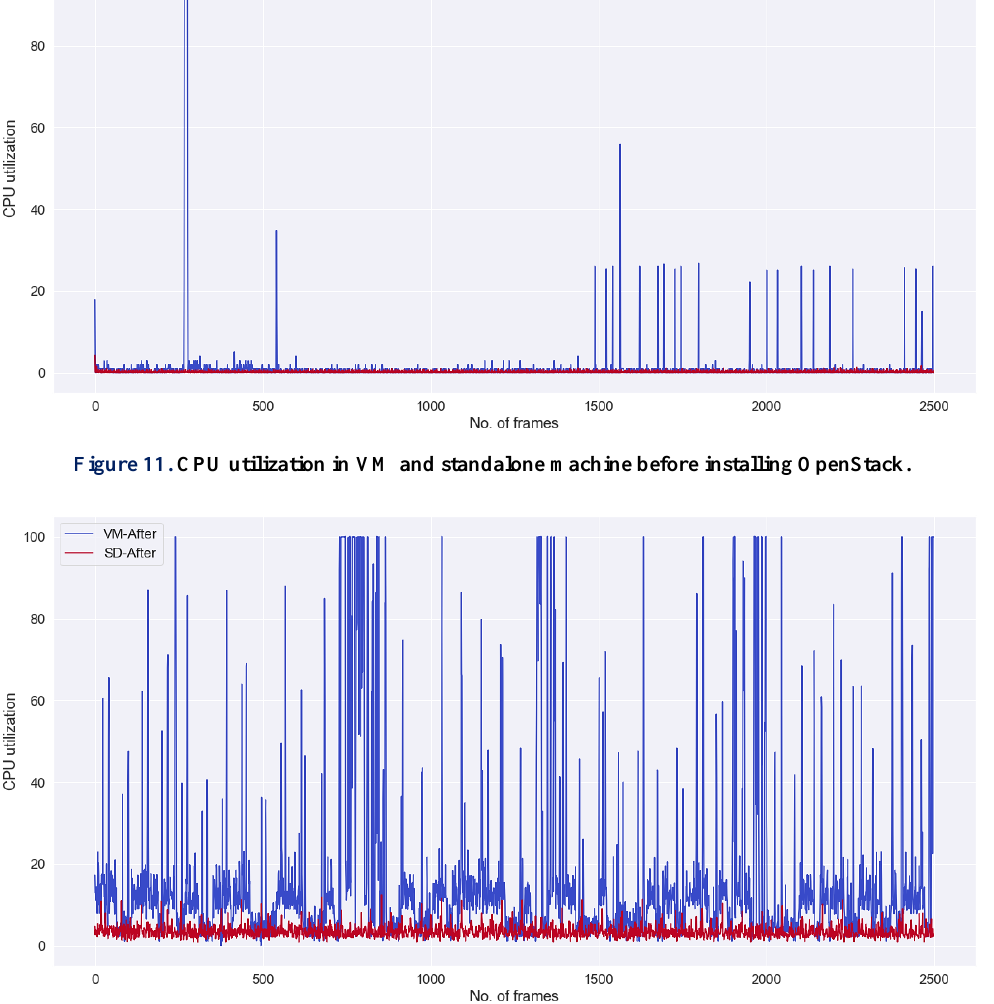
Figure 12. CPU utilization in VM and standalone machine after installing OpenStack.